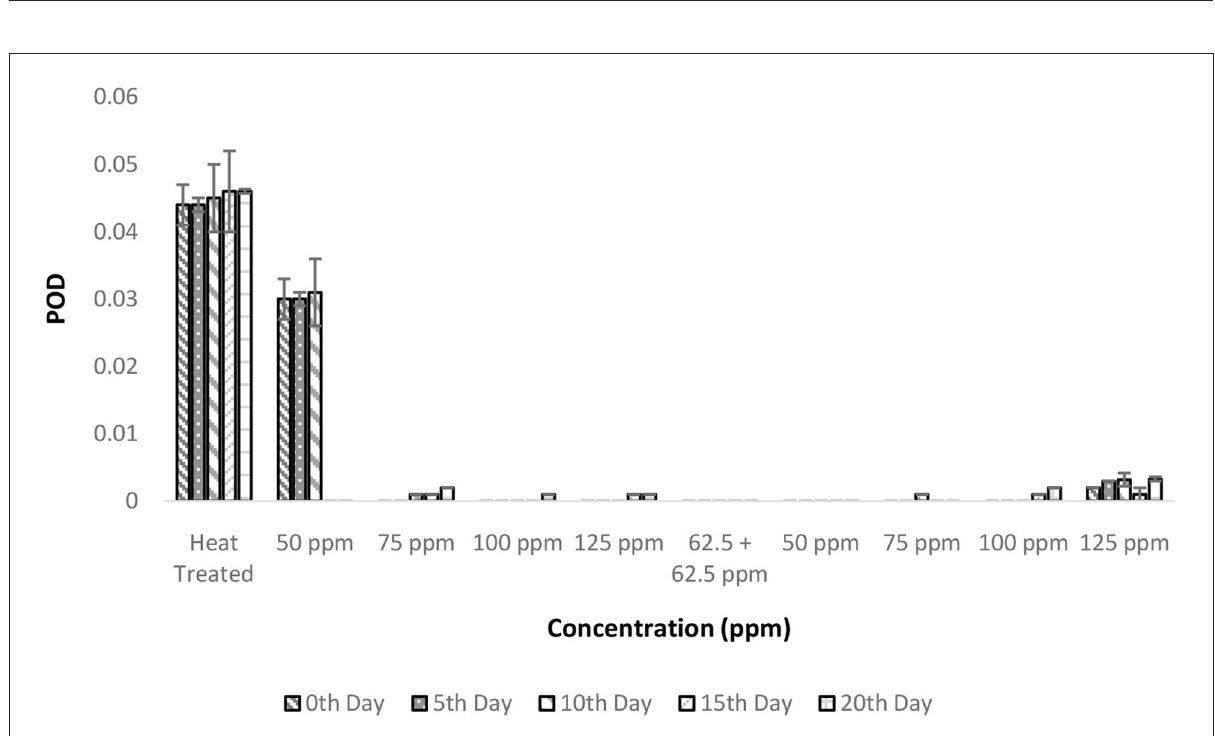
FIGURE6 Peroxidase activity (POD) vs. concentration plot of bio-preservatives during the storage